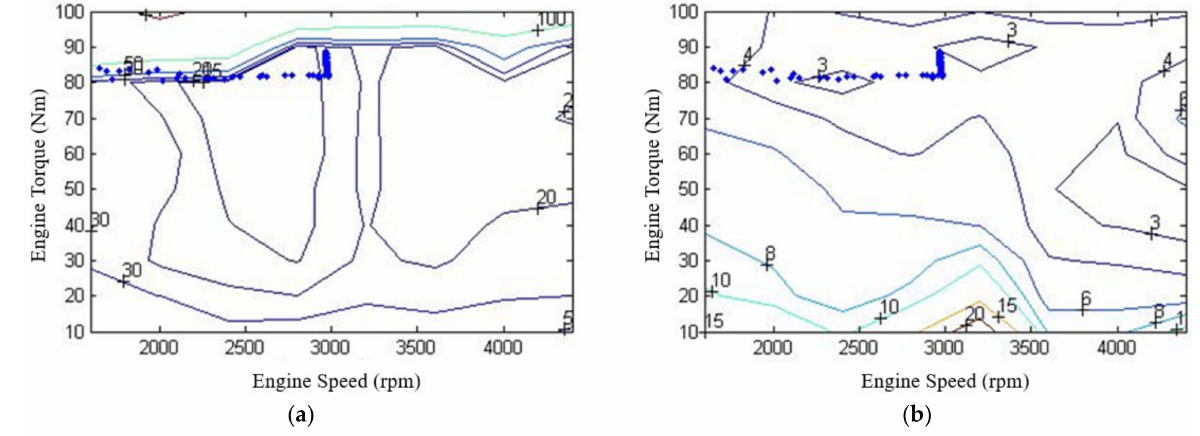
Figure 11. ICE pollutant emission map with the NEDC2000 driving cycle: ( a ) brake-specific carbon monoxide emission (BSCO) and ( b ) brake-specific hydrocarbons (BSHCs).